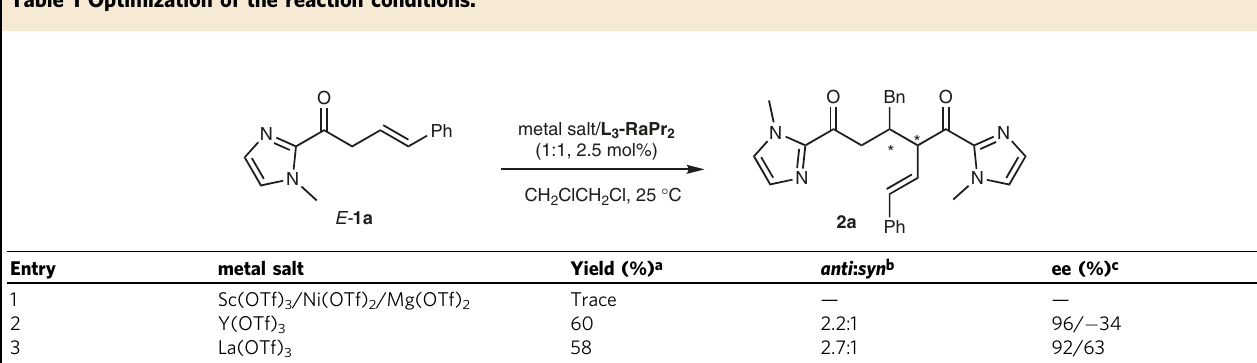
Table 1 Optimization of the reaction